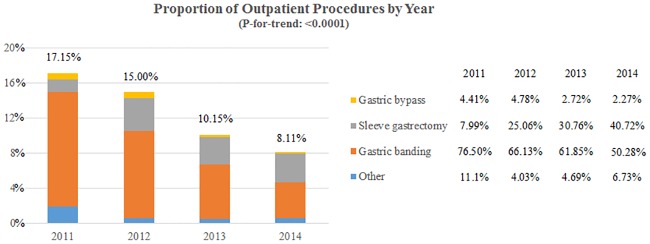
Proportion of outpatient procedures from 2011 to 2014.